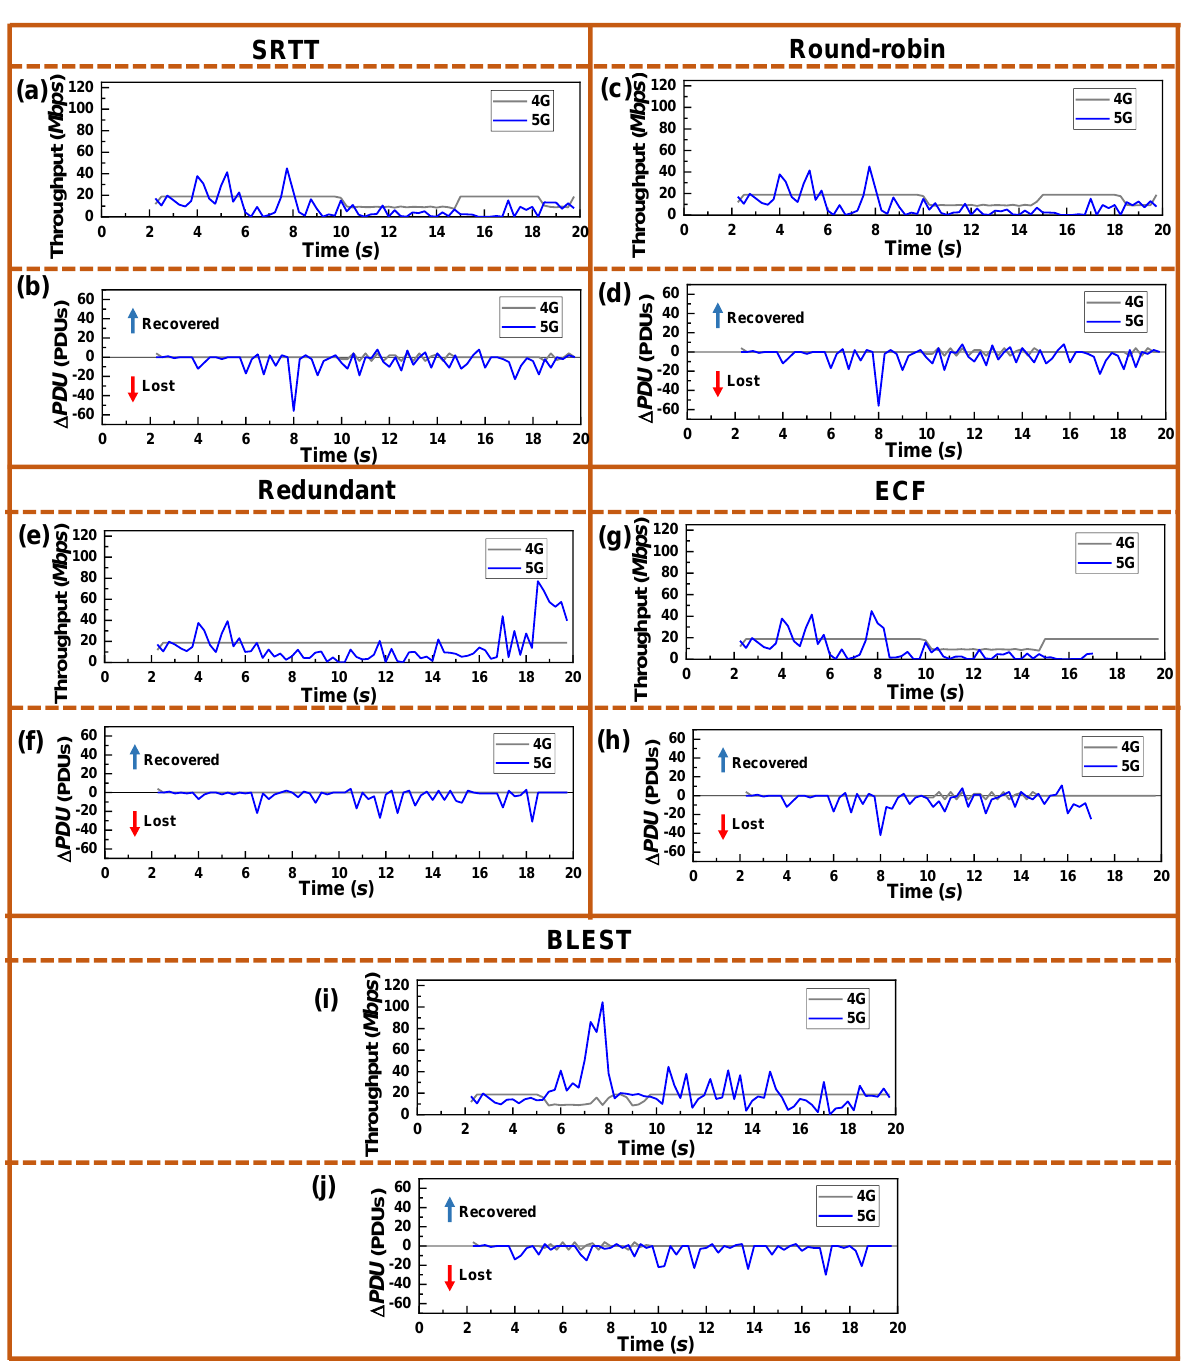
Figure 7. Real-time performance of the tested MPTCP schedulers for OLIA as a CCA in terms of throughput and Δ PDU for: ( a , b ) SRTT, ( c , d ) Round-robin, ( e , f ) Redundant, ( g , h ) ECF, and ( i , j ) BLEST, respectively.